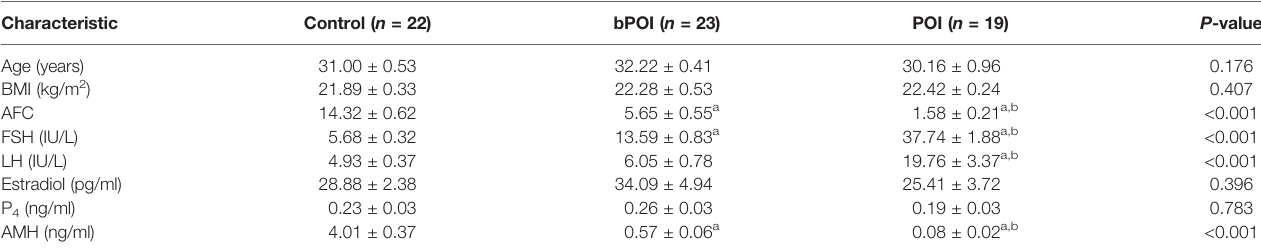
Hormonelevelsweremeasuredinserumonday3ofthemenstrualcycle.AFCwasdetectedasthenumberoffollicles(3 – 8mmindiameter)bytransvaginalultrasoundscanduringtheearly follicular phase. bPOI, biochemical premature ovarian insuf fi ciency; POI, premature ovarian insuf fi ciency; AFC, antral follicle count; FSH, follicle-stimulating hormone; LH, luteinizing hormone; P 4 , progesterone; AMH, anti-Müllerian hormone. a P < 0.05 vs. control. b P < 0.05 vs.